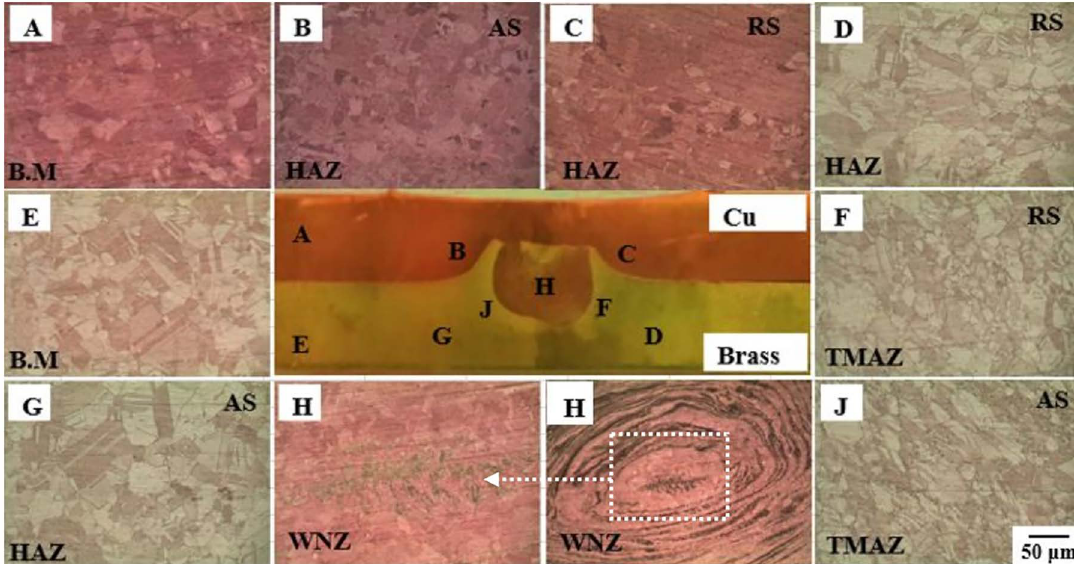
Figure 5. Optical macrostructure and microstructure of different weld zone in case A with the welding condition of 450 rpm and 16 mm/min.